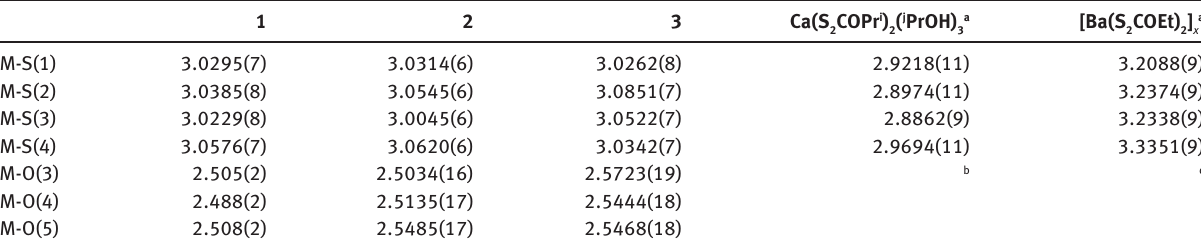
Table 1 Comparative bond lengths (Å) for compounds 1 – 3 and related